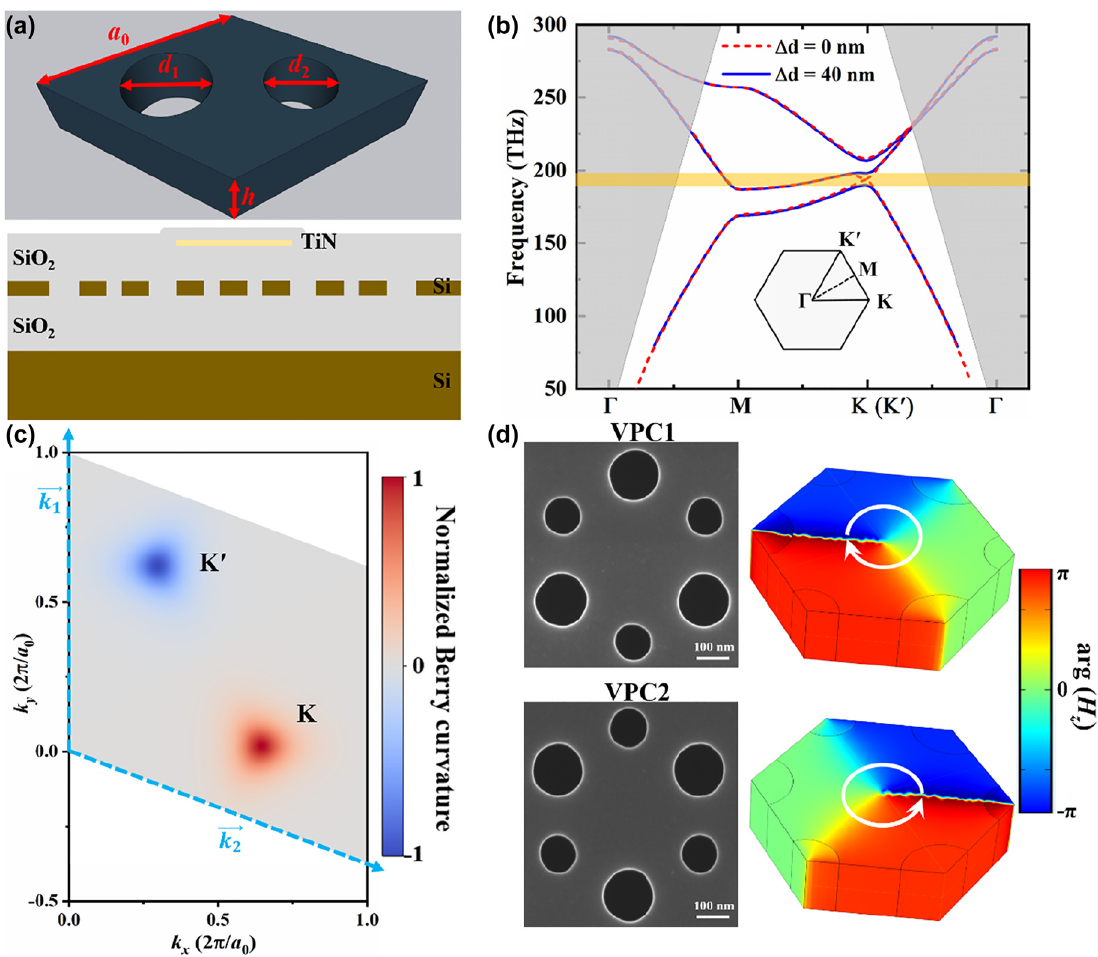
Figure 1: The configuration and band diagram of the proposed VPC. (a) Three-dimensional (3D) schematic view of the rhombic unit cell of holes with different diameters. The cross-sectional view of the VPC with a heat electrode (lower). lattice (upper), comprised by two SiO 2 (b) Bulk band diagrams for the unperturbed (red dashed line) and perturbed (blue solid line) VPCs. The inset shows the FBZ of the proposed VPC. The grey region represents the radiation zone. (c) Normalized valley-dependent Berry curvatures of the lowest band near the K and K ′ ⃗ ⃗ points in the momentum space. And phase vortex profiles at the K valley k 1 and k 2 are the reciprocal lattice vectors. (d) SEM pictures and H z holes for VPC and VPC , of the unit cells comprised by two inequivalent SiO 2 1 2